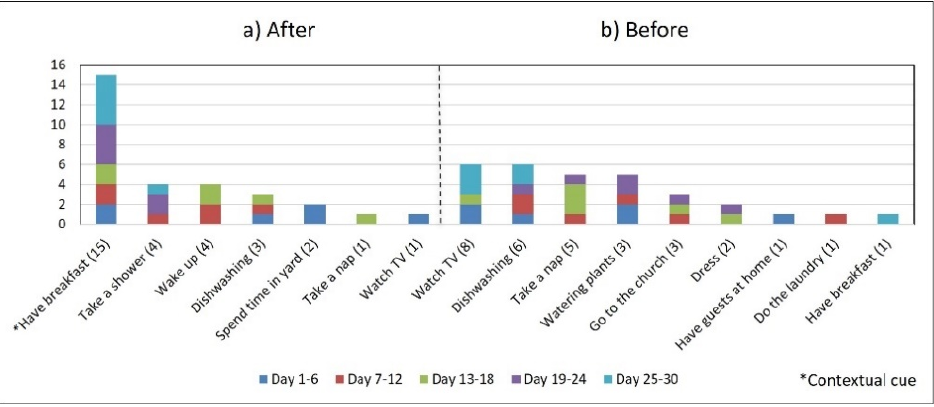
Figure 3. Medication behavior of S1 shows the time of day in which the group of medication (G2) was taken daily and whether G2 was associated with the activity set as the contextual cue. Figure 4. The number of days S1 performed the medication episode (G2-AM) after and before the reported activities.